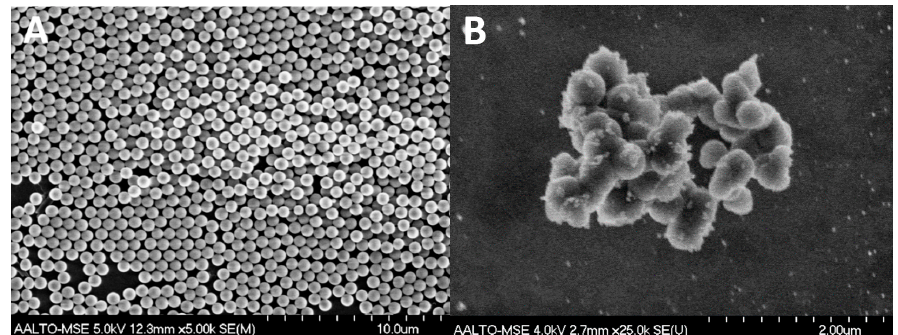
Figure 1. SEM images showing ( A ) the spherical pristine SiO 2 particles; and ( B ) the raspberry-like Ag–SiO 2 composite with surface-immobilized Ag